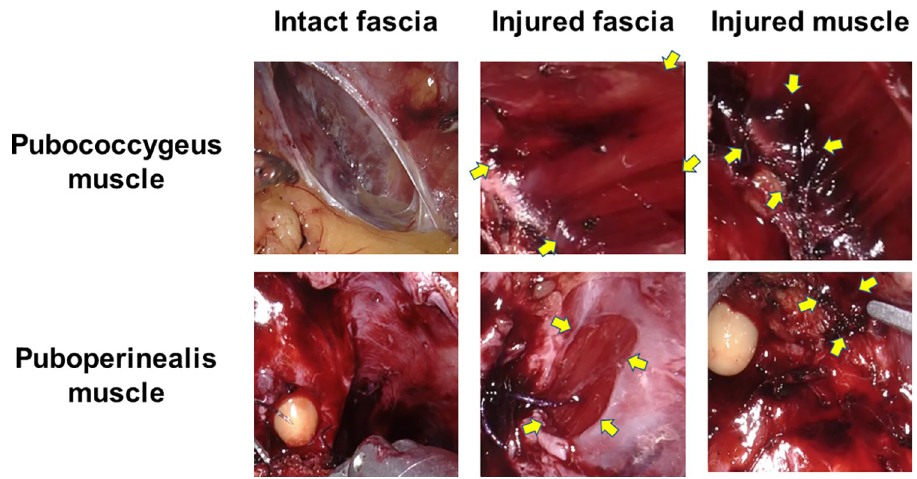
Fig 1. Representative pictures of intact fascia, injured fascia, and injured muscle of the pubococcygeus and puboperineal muscles. Yellow arrows indicate the area of injury.